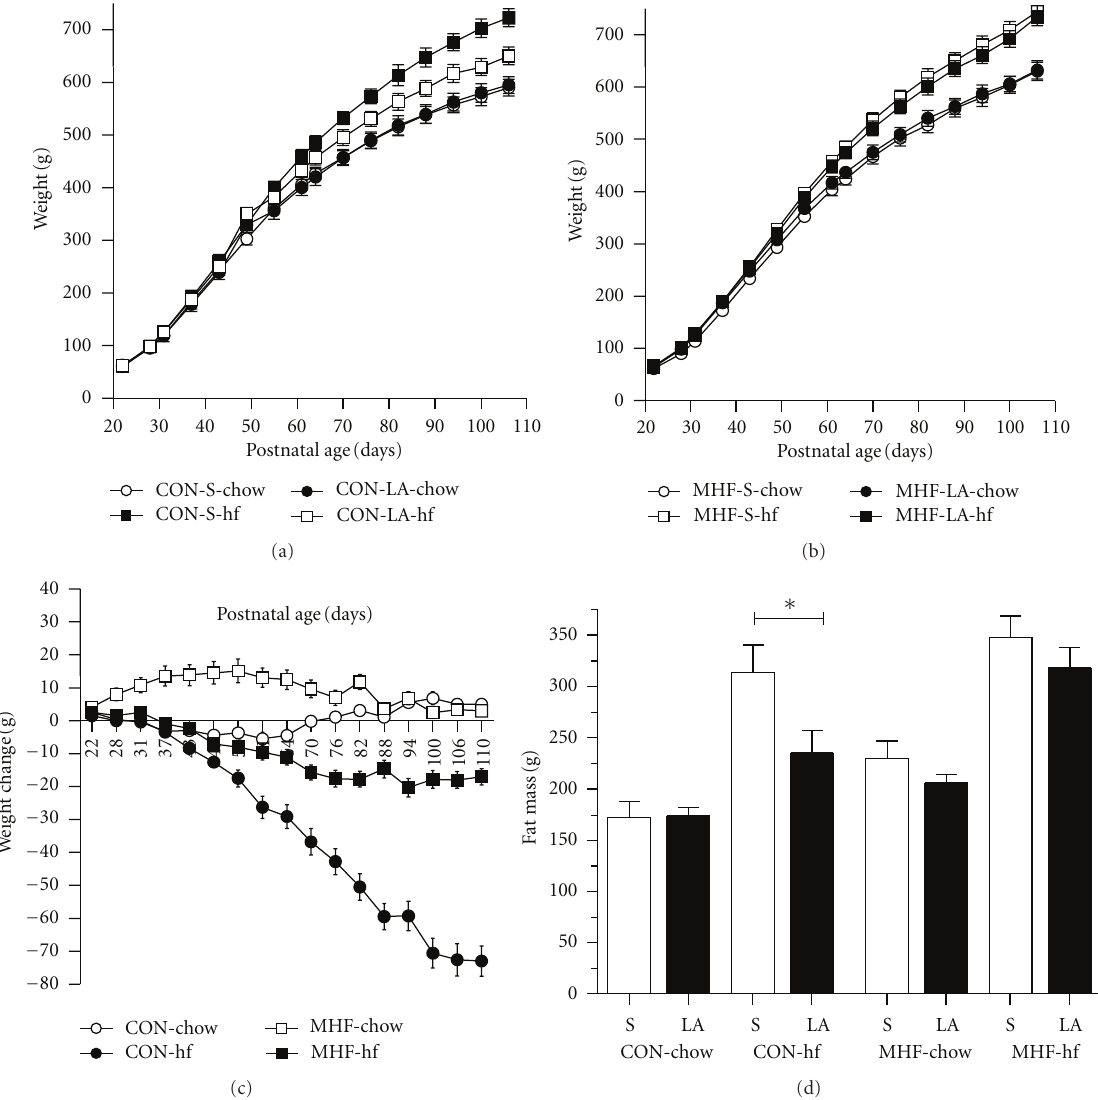
Figure 4: Body weights in male o ff spring of either CON (a) or MHF (b) mothers treated with either saline or LA as neonates and fed either a chow or hf diet after weaning. Data are means ± SEM, n = minimum 8 per group; (c) change in body weight (grams, shown as delta di ff erence in body weight between LA and Sal-treated o ff spring, Δ LA-Sal) in CON and MHF o ff spring fed either a control chow or hf diet from weaning until postnatal day 110. Data are means ± SEM, n = minimum 8 per group. Maternal diet × LA treatment interaction P < 0 . 005; (d) fat mass (g) as quantified by DEXA scanning in o ff spring of CON of MHF dams, treated with either Sal or LA as neonates and fed either a control chow or hf diet after weaning. Data are means ± SEM, minimum of 8 per group. ∗ P < 0 .